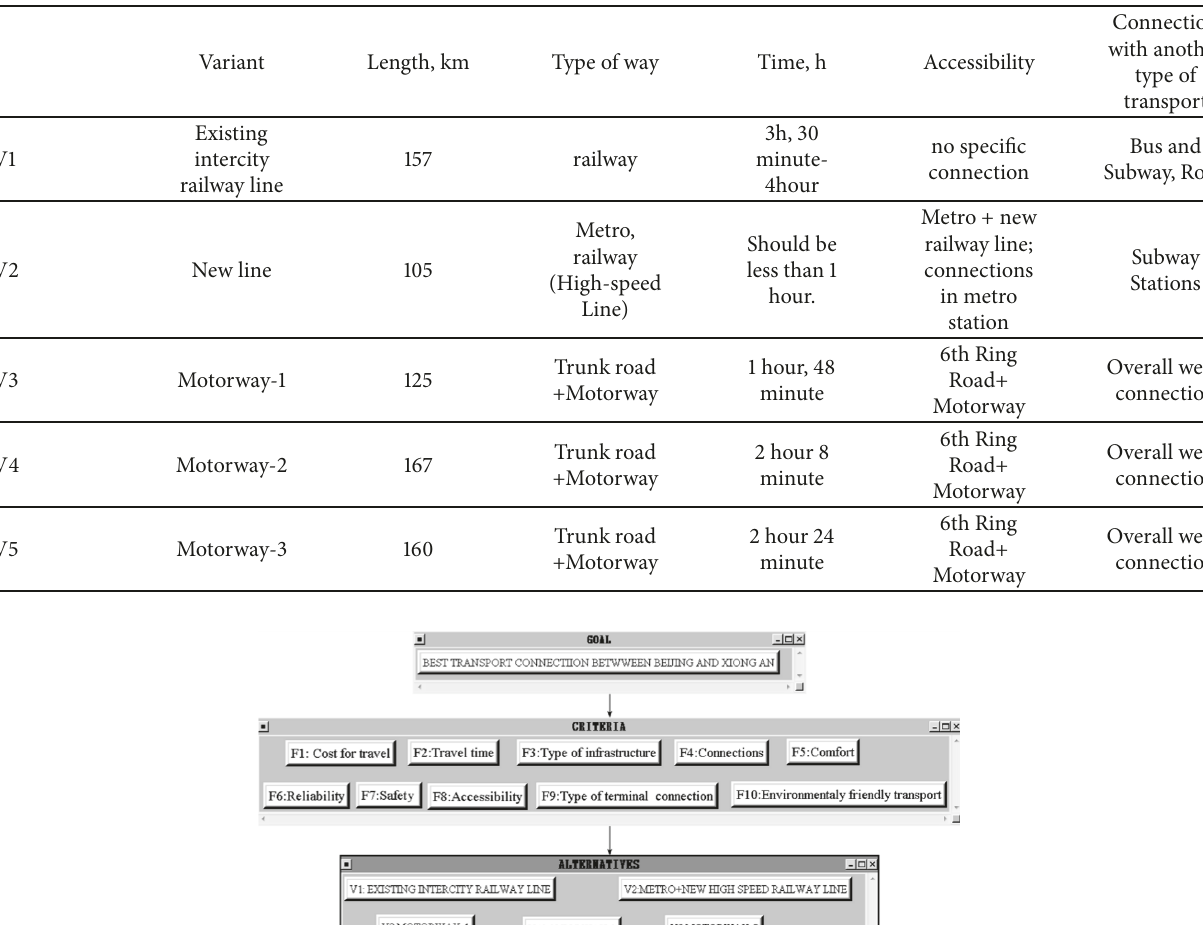
Table 1: Characteristics of variants.